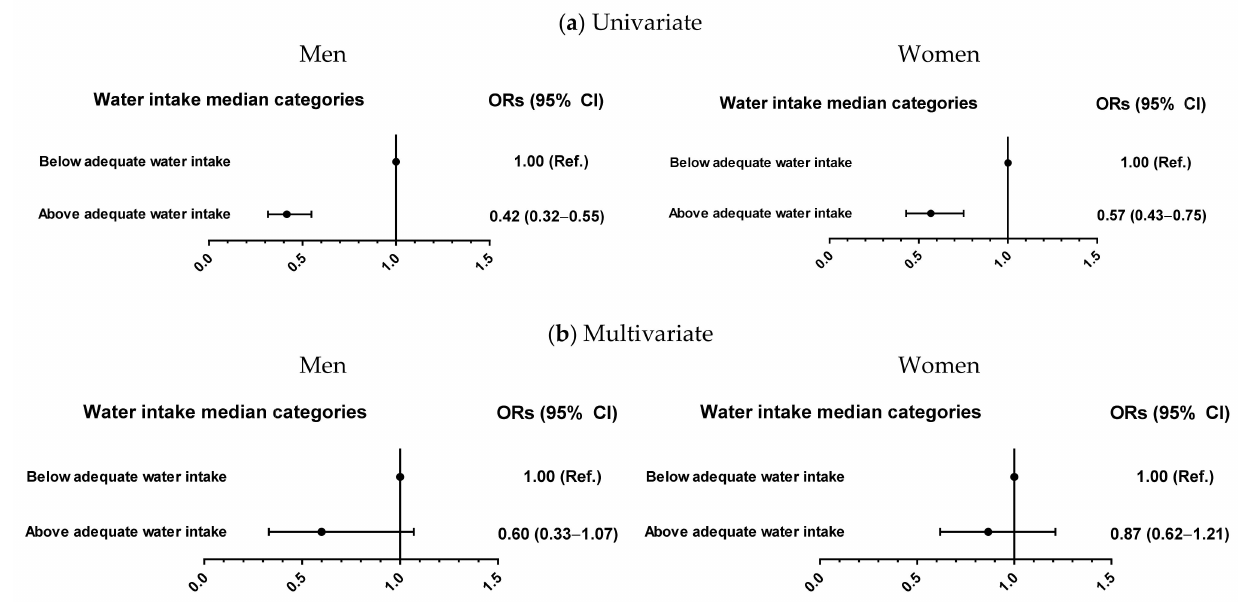
Figure 4. Odds ratio (95% confidence interval) for low muscle strength according to median water intake ( a ) before and ( b ) after adjustment for confounding variables in men and women by logistic regression analyses. Confounding variables included age, body mass index, smoking status, heavy alcohol drinking, resistance exercise, total energy intake, and protein intake. The cutoffs defining adequate water intake were >1000 mL in men and >900 mL in women. The cutoffs for hand grip strength defining low muscle strength were 28.6 kg in men and 16.4 kg in women. Abbreviations: ORs, odds